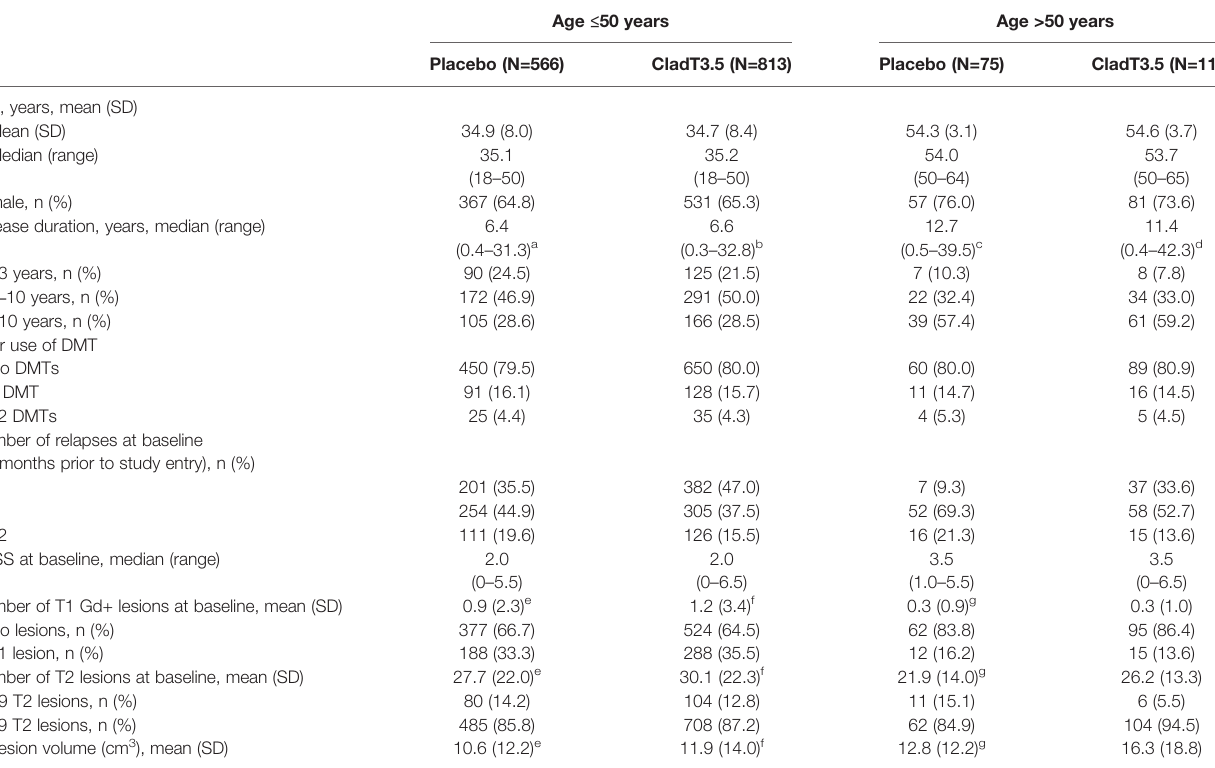
TABLE 1 | Baseline demographics and disease characteristics of patients in the ≤ 50 and >50 years age groups.